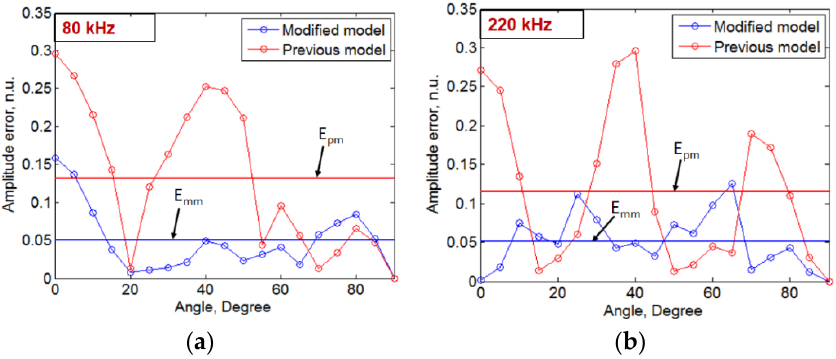
Figure 10. Comparison of amplitude errors in the results obtained by modified model and previously developed model in the case of 80 kHz ( a ) and 220 kHz ( b ) ( E pm -Mean error in the previous model, E mm -Mean error in the modified model).